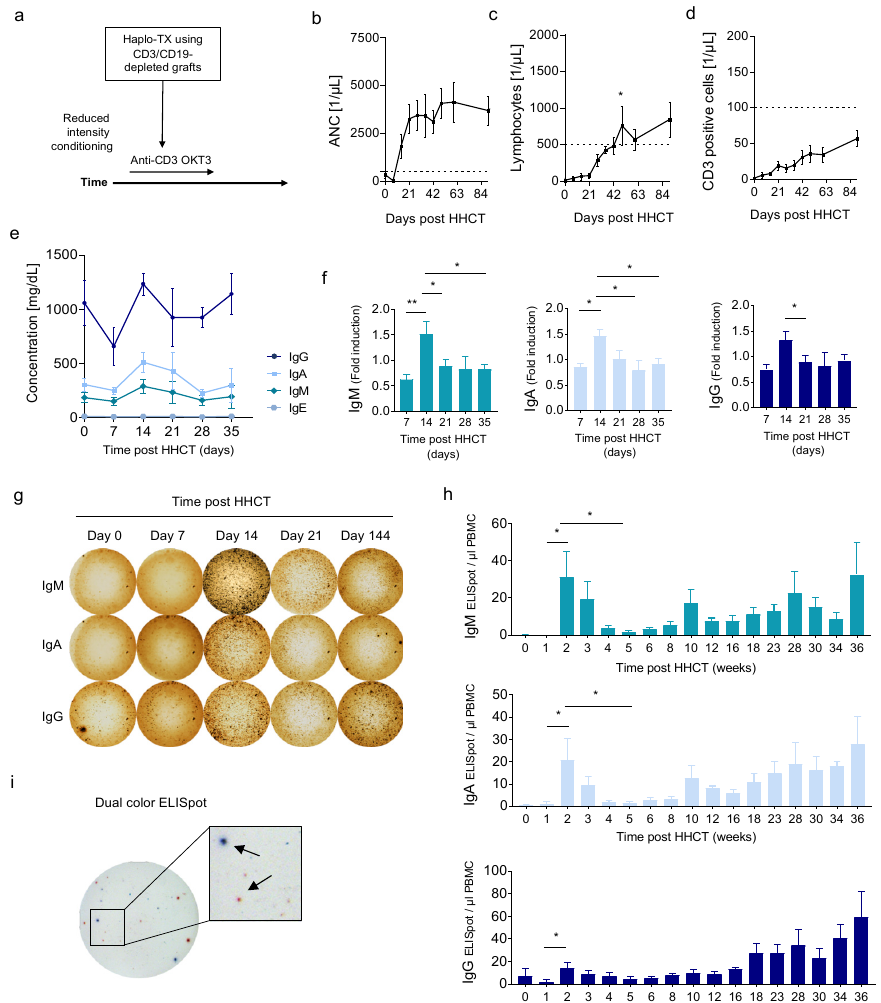
Figure 1. Immune cell reconstitution, detection of immunoglobulins and ASC after HHCT. ( a ) Schematic illustration of the study protocol (NCT00202917) ( b ) Reconstitution of absolute neutrophil count (ANC) after HHCT. Median on day + 14 (1815 cells/ μ L). ( c ) Reconstitution of lymphocytes after HHCT. Median on day + 14 (64 cells/ μ L). ( d ) Reconstitution of CD3 positive cells. Median on day + 14 (8 cells/ μ L). ( b – d ) Dotted line: clinically relevant lower threshold. ( e ) Serum level of IgG, IgA, IgM and IgE (mg/dL) after HHCT. ( f ) Fold induction (referring to day 0) of IgM, IgA and IgG in week 1–5 after HHCT. ( g ) Representative IgM, IgA and IgG B cell ELISpots on day 0, 7, 14, 21 and 144 after HHCT. ( h ) Quantification of IgM, IgA and IgG ELISpots/ µ L PBMC between week 0–35 after HHCT. ( i ) Dual color IgG, IgM B cell Immunospot. * < 0.05, ** < 0.01.